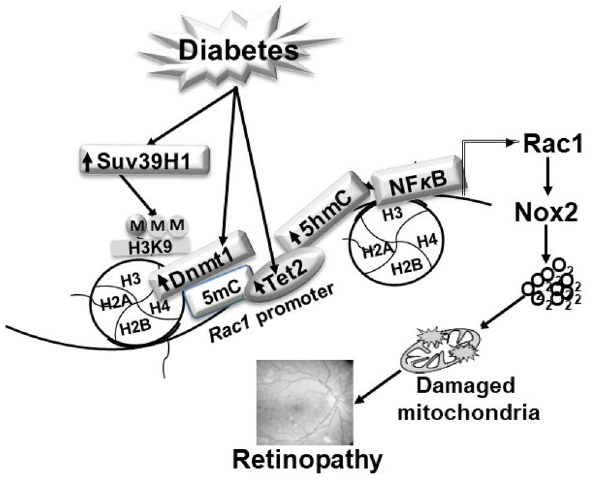
Figure 7. Working model: Diabetes activates Suv39H1, and this increases H3K9me3 at Rac1 promoter, creating a mark on the chromatin for Dnmt1 binding. Concomitant activation of Dnmts and Tets hydroxymethylates 5mC to 5 hmC, facilitating the binding of the transcription factor and induction of Rac1 transcription. Activation of Rac1-Nox2-ROS damages the mitochondria, ultimately leading to the development of diabetic